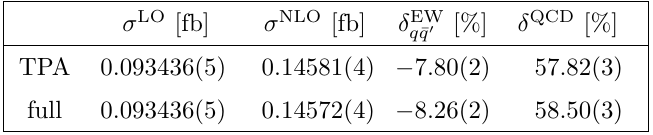
Table 7. Comparison of the LO and the NLO cross sections, (cid:27) LO and (cid:27) NLO , and the relevant NLO corrections (cid:14) EW and (cid:14) QCD for the TPA and the full o(cid:11)-shell calculation for the process q (cid:22) q 0 p pp ! e (cid:0) (cid:22) (cid:23) e (cid:22) + (cid:23) (cid:22) (cid:28) + (cid:23) (cid:28) + X at a CM energy of s = 13 TeV. Monte Carlo integration errors are indicated in